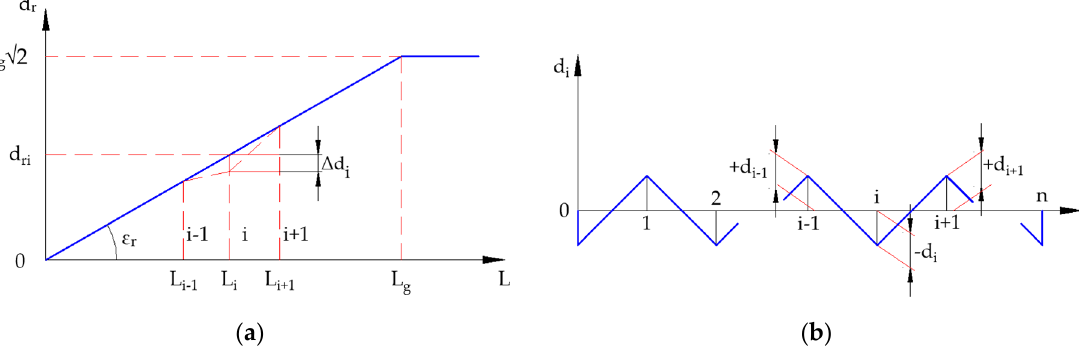
Figure 6. Simplified models for the ground motion spatial variation effect, as per Eurocode 8 ( a ) Set A; ( b ) Set B [6].